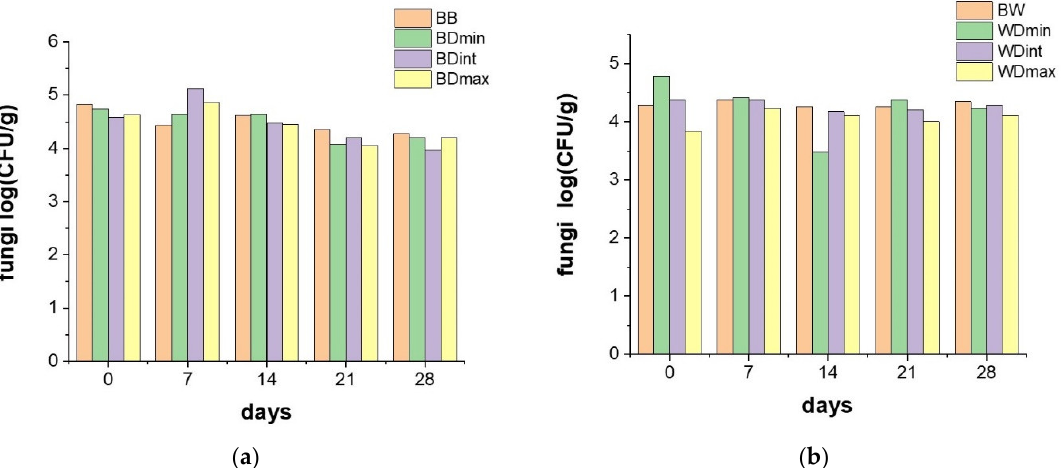
Figure 6. The effects of the treatment of barley ( a ) and wheat seeds ( b ) with TTZ on communities of fungi, recorded every 7 days for 28 days: BB and BW—seeds untreated with triticonazole, BDmin, and WDmin—barley and wheat seeds treated with the minimum dose, DBint, and WDint—barley and wheat seeds treated with the intermediate dose, BDmax, and WDmax—barley and wheat seeds treated with the maximum dose of triticonazole. The population of fungi in the soil cultivated with wheat and barley seeds treated with TTZ decreased slightly during the first 21 days of incubation; the decrease was not dependent on the dose of TTZ used (Figure 6).